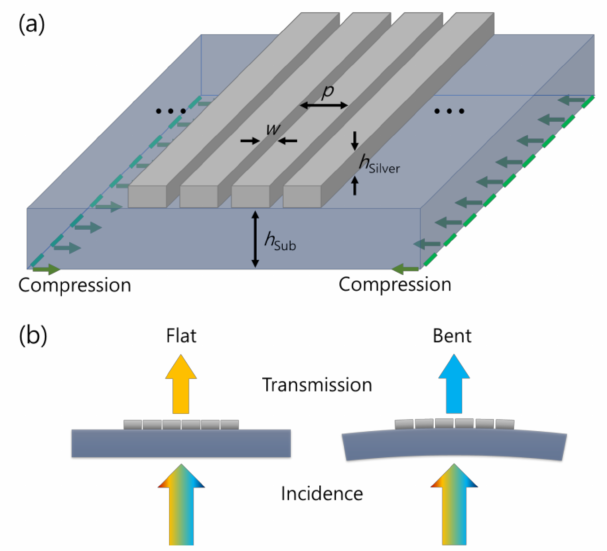
Figure 1. Concept of the nanogap slit system on a PDMS substrate. ( a ) A schematic of the slit array geometry denoting some important geometrical factors. w 0 = 3 nm, p = 500 nm, h Silver = 200 nm and h Sub = 250 µ m. The green arrows denote direction of the displacement applied in the structural mechanic’s simulation for outer bending. ( b ) An operation schematic of the nanogap slit as a variable plasmonic